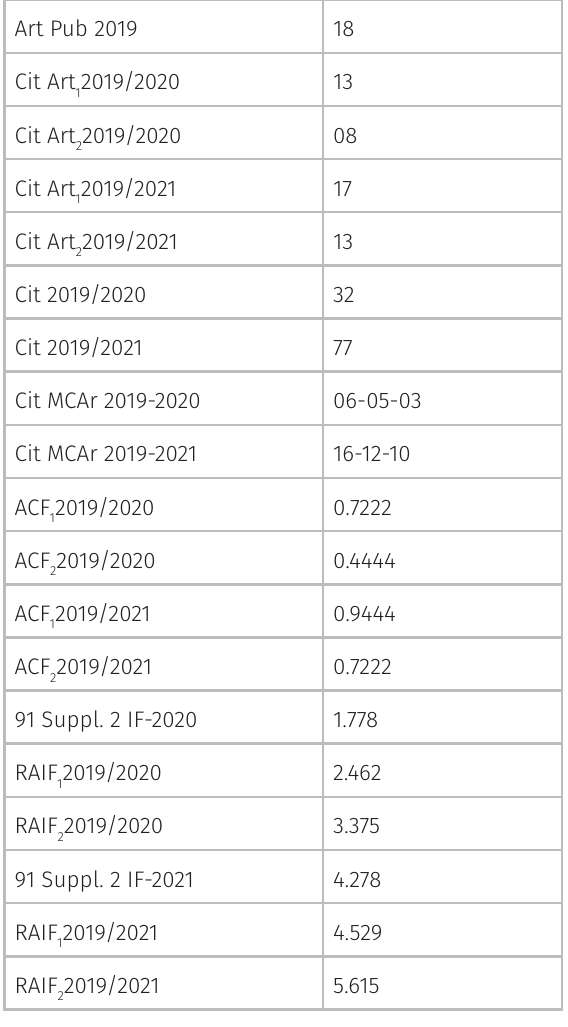
Table I. Citations and indexes concerning the articles on Paleontology published in the issue 91 Supplement 2 by the Annals of the Brazilian Academy of Sciences that have been considered in the Impact Factor of 2020 and